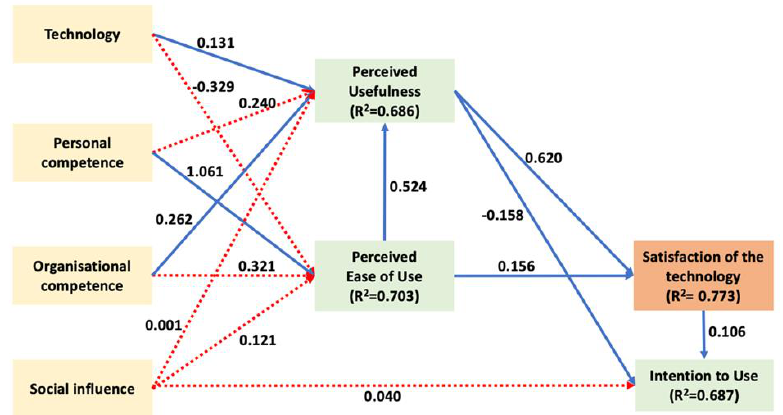
Figure 4. Results of hypothesis testing for large-sized enterprises.